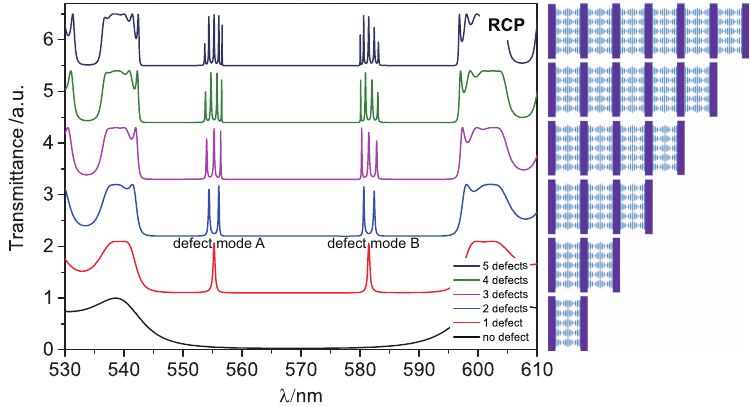
Figure 2. Transmission spectra (for RCP light) of composite structures with varying number of structural units. The thicknesses of the CLC and polymer layer are 4 µ m and 2 µ m,